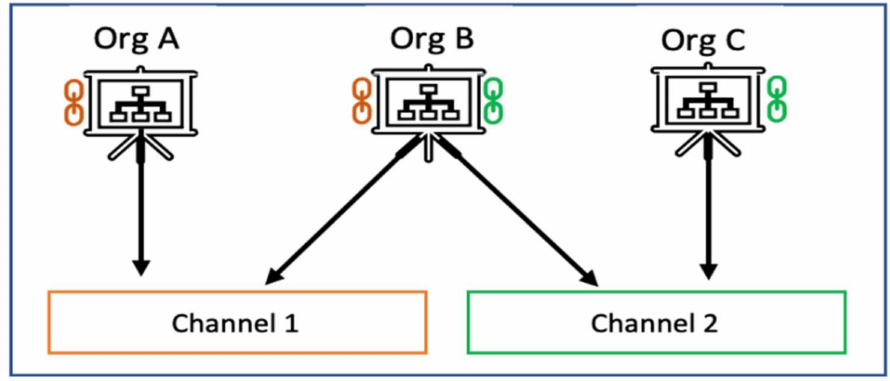
Figure 1. Channel structure. Source: